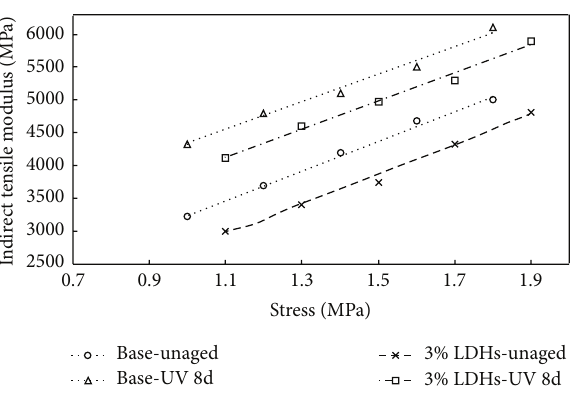
Figure 9: Double logarithmic diagram of fatigue life and loading stress at 5 ∘